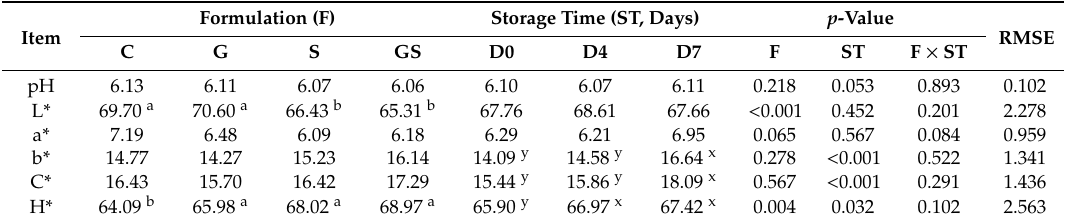
Table 2. pH and colour parameters of cooked rabbit burgers.